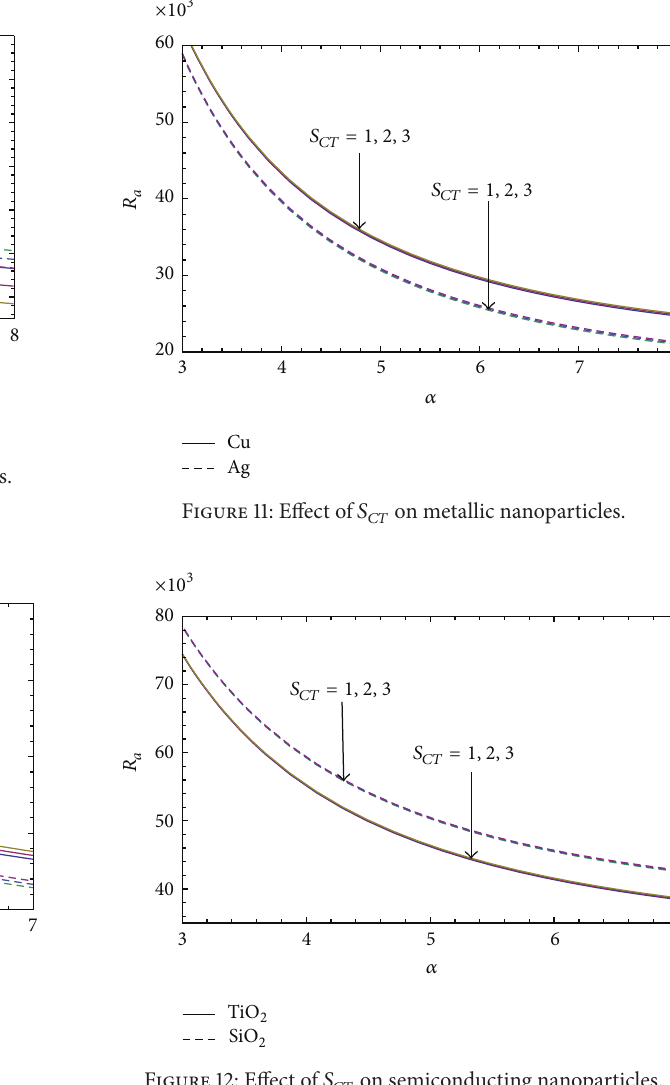
Figure 12: Effect of 𝑆 𝐶𝑇 on semiconducting